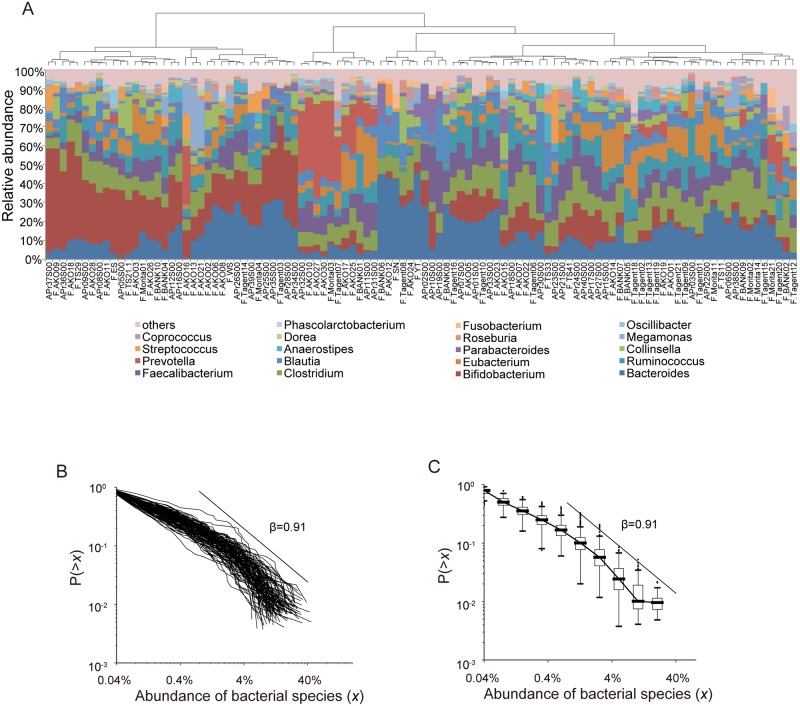
CRADs of human gut microbiomes.A: Clustering of the 104 healthy Japanese samples. Hierarchal clustering is performed at the genus-level abundance of the 104 Japanese samples based on Bray-Curtis distances. B: Individual CRADs of the 104 healthy Japanese gut microbiomes based on the OTU-level composition. C: Median CRADs of the same samples as those in (B).